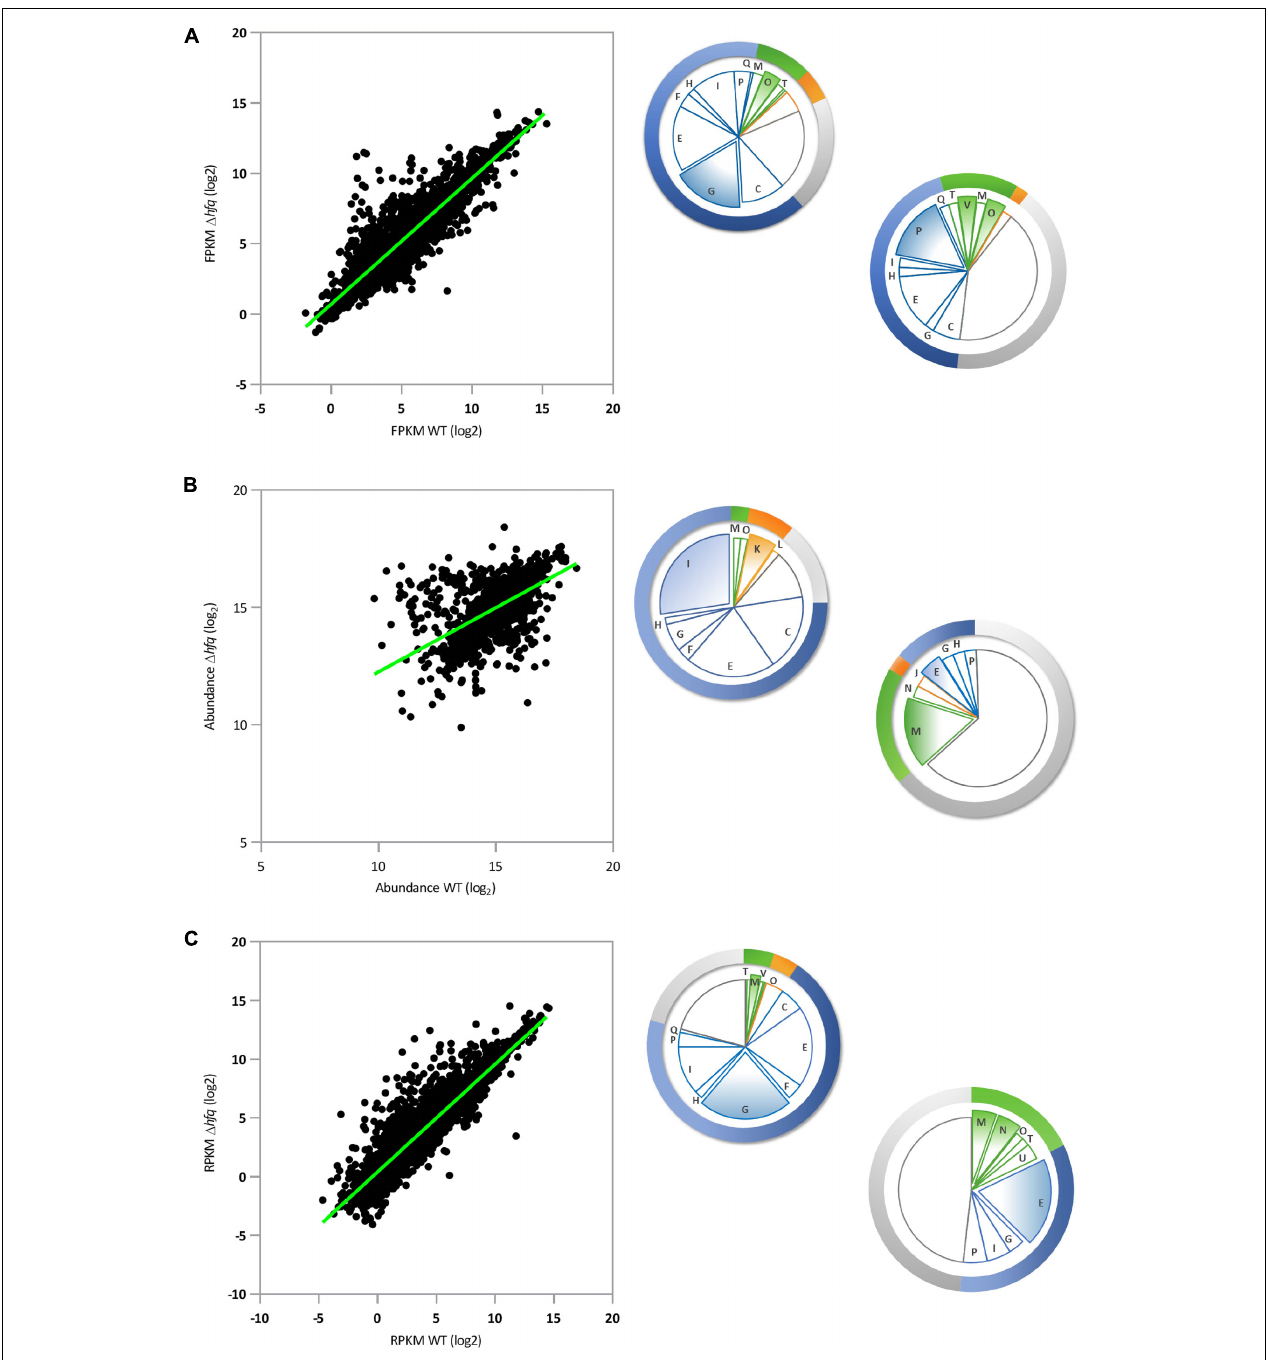
FIGURE 1 | Parallel global analyses of the P. fluorescens (cid:49) hfq mutant. (A) Transcriptomic analysis: Scatter-plot representing pairwise comparison of mean log 2 FPKM expression values for P. fluorescens WT and (cid:49) hfq ( n = 5910). (B) Proteomic analysis: Scatter-plot representing pairwise comparison of mean log 2 protein abundance values for P. fluorescens WT and (cid:49) hfq ( n = 2019). (C) Translatomic analysis: Scatter-plot representing pairwise comparison of mean log 2 RPKM expression values for P. fluorescens WT and (cid:49) hfq ( n = 5910). The pie chart sections indicate the proportion of significantly up- (top left) or down- (bottom right) regulated genes in the (cid:49) hfq background (according to the COG database) in each functional category. Categories are color-coded as follows: blue – metabolism, green – cellular processes and signaling, orange – information storage and processing, and gray – poorly characterized. The letters in each section of the chart refer to the respective COG functional categories. The most abundant categories are expanded from the chart in each case. A complete list of genes and information on their predicted functions are given in Supplementary Table S1 .